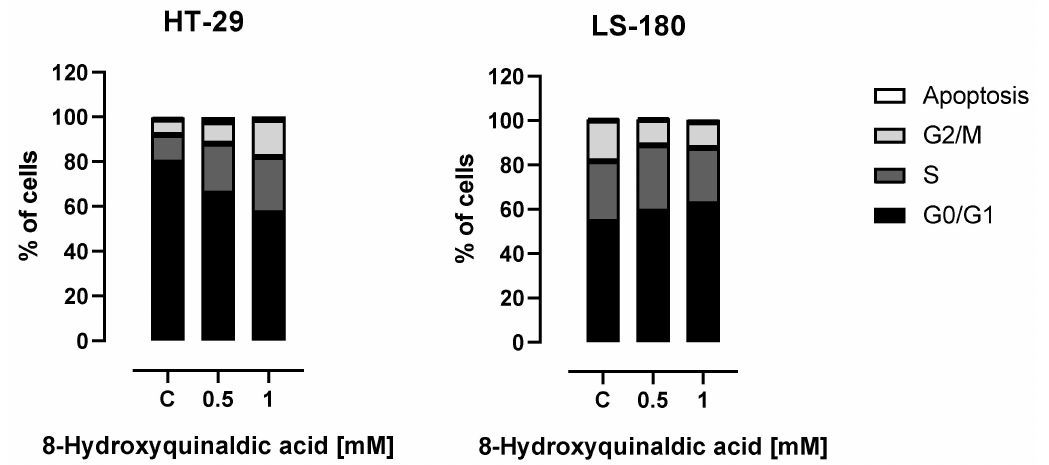
Figure 4. The e ff ect of 8-hydroxyquinaldic acid on the cell cycle in human colon adenocarcinoma cells. HT-29 and LS-180 cells were exposed to culture medium (control, C) or selected dilutions of 8-hydroxyquinaldic acid (0.5; 1 mM) in culture medium for 24 h. The cell cycle progression was assessed in a flow cytometer using the propidium iodide method described previously in [18]. The experiment was run in triplicate. Cell separation to G0 / G1, S, and G2 / M phases and the apoptotic groupwas presented as a percentage of total number of